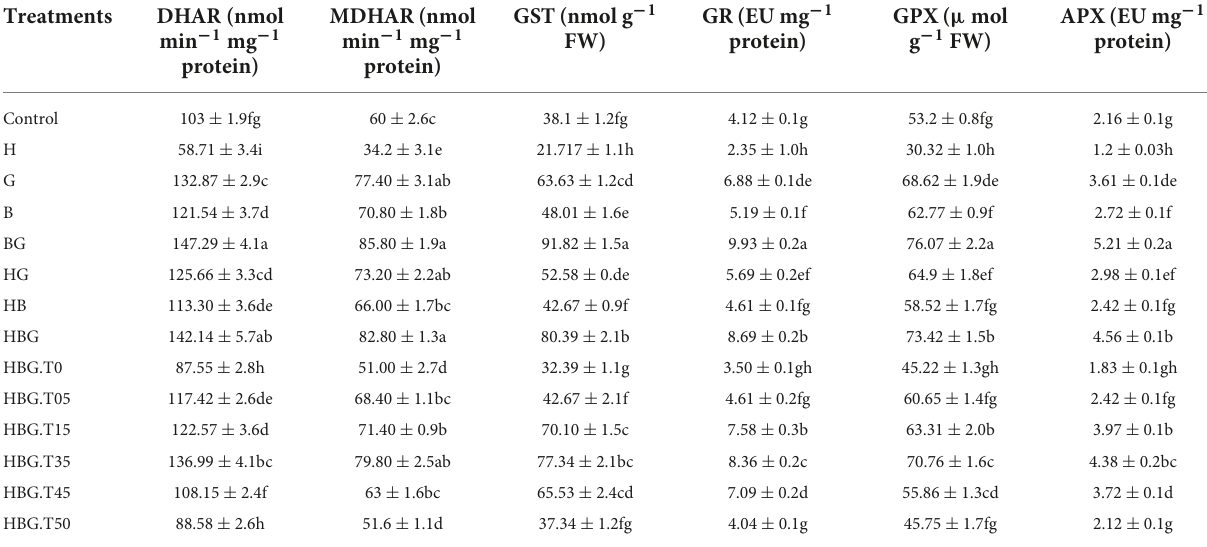
TABLE 2 Effect of GA 3 on dehydroascorbate reductase (DHAR), monodehydroascorbate reductase (MDHAR), glutathione-s-transferase (GST), glutathione reductase (GR), glutathione peroxidase (GPX), and ascorbate peroxidase (APX), in Brassica alboglabra under temperature stress, and hexachlorobenzebe (HCB)